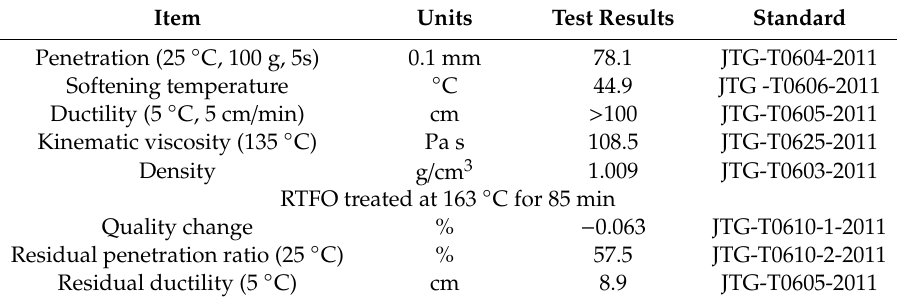
Table 1. Properties of base asphalt binder.